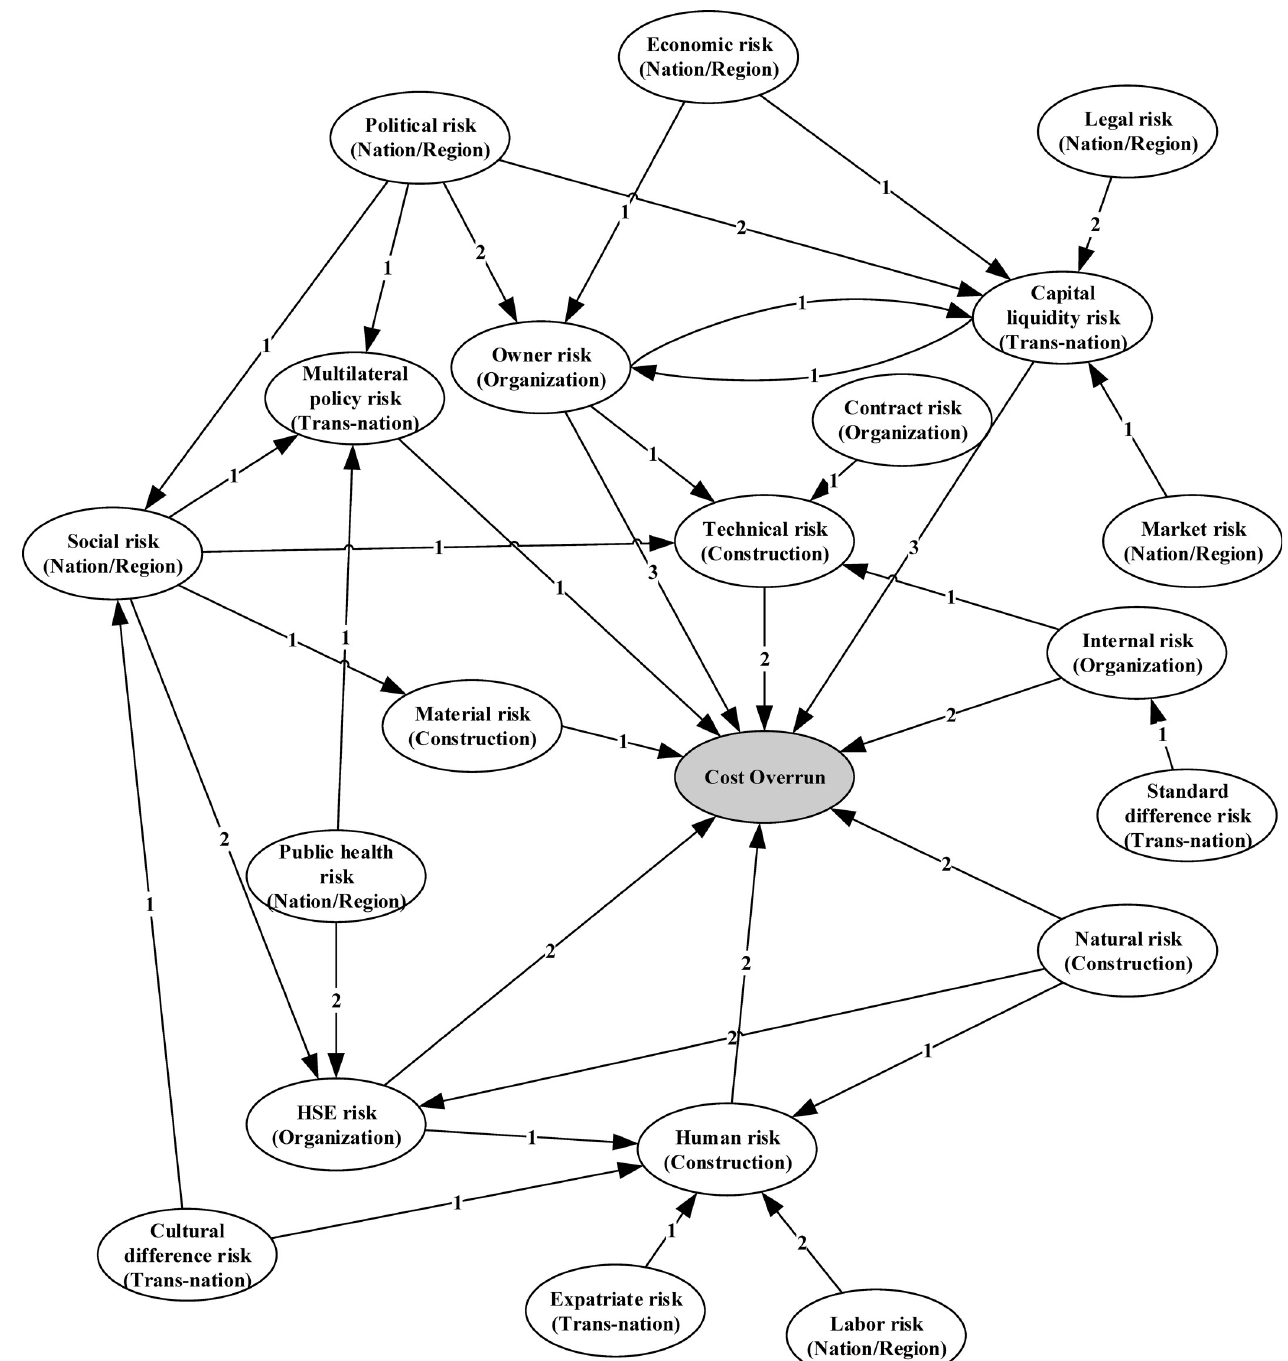
Fig 2. Diagram of the initial risk network for the target